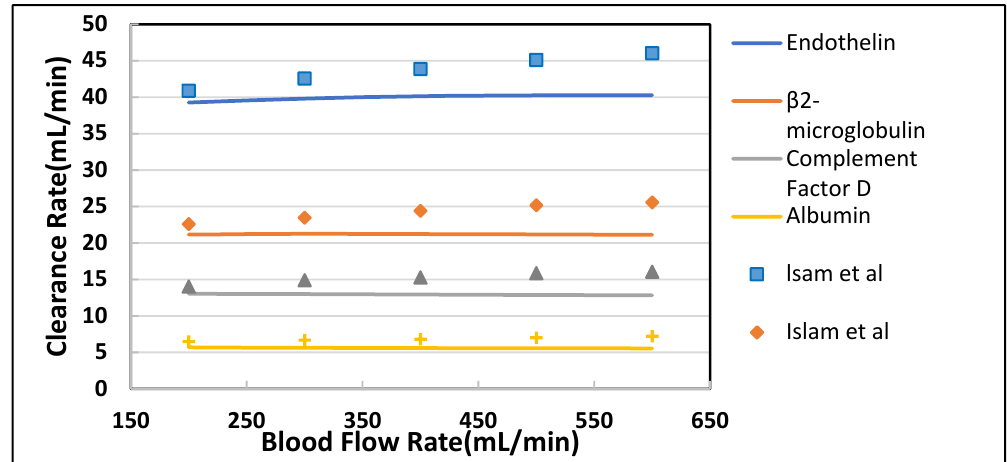
Figure 6. The model predicted (solid lines) vs. in vivo and silico (symbols) solute clearances plotted against varying blood flow rate at Q D = 500 mL / min.